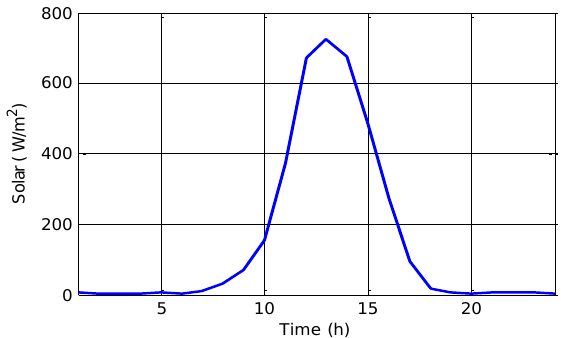
Figure 6. The 24 h wind profile of the studied system.